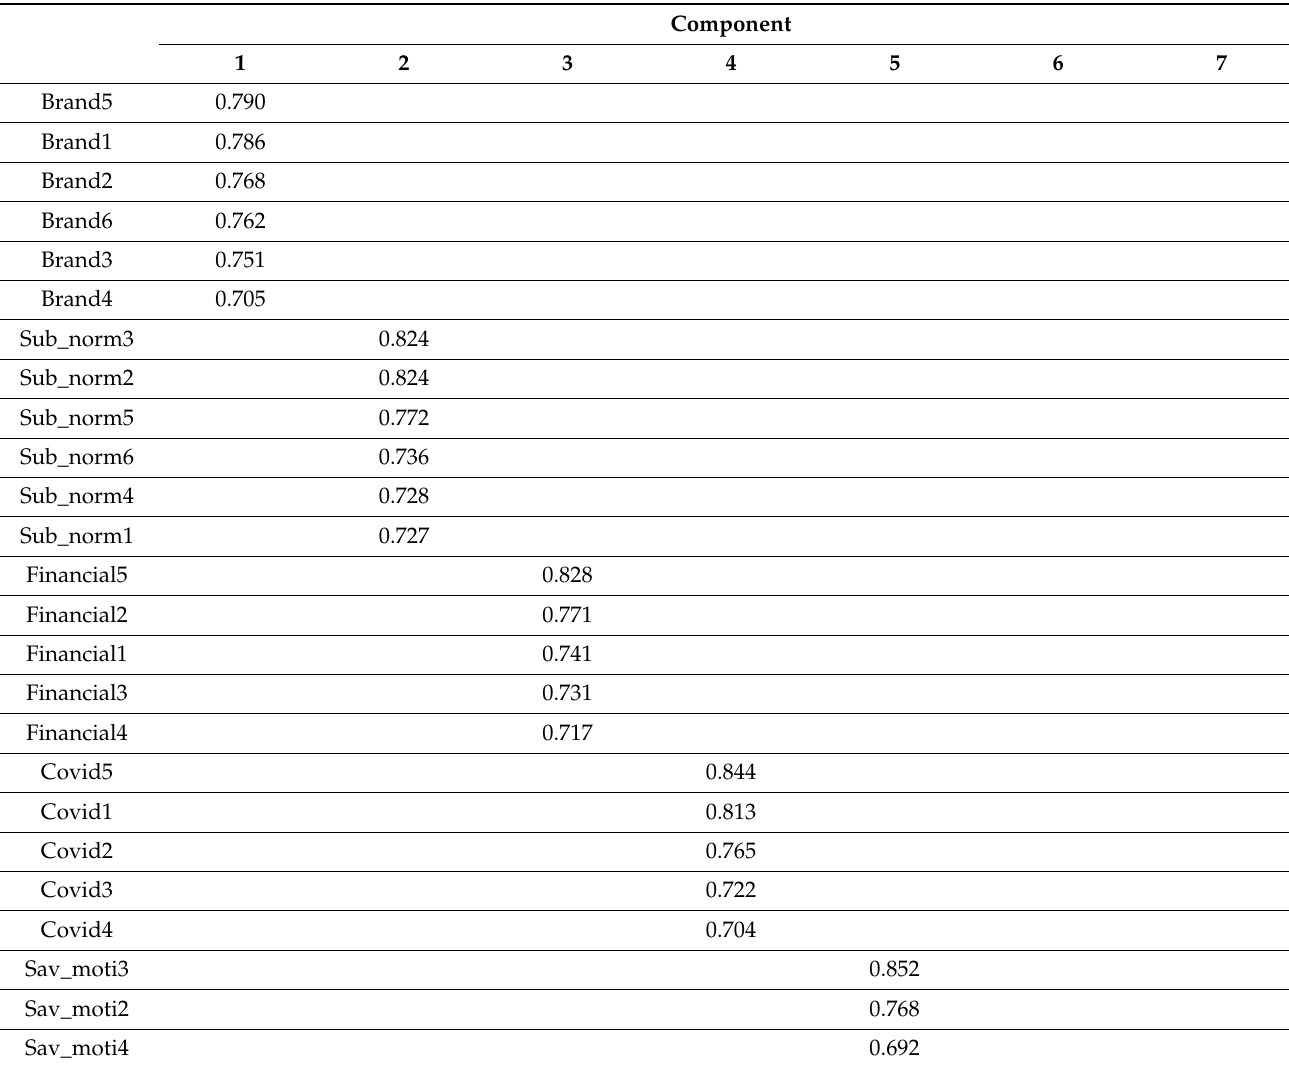
Table 5. Rotated Component